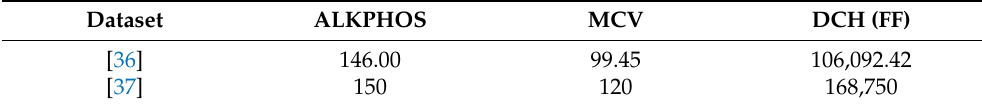
Table 5. The best individual found in case 1 for datasets